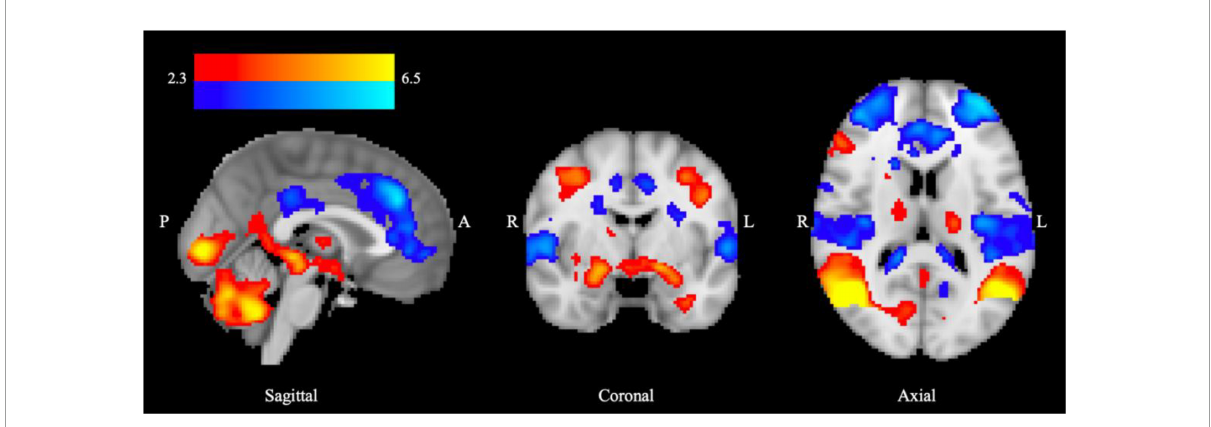
FIGURE1 BOLD response to aversive processing in all groups combined following placebo administration. Increased limbic BOLD signal across HD and DD groups for the aversive > neutral contrast is denoted in red, and decreased fronto-cortical BOLD signal indicated in blue. Color bar shows z -stat values representing average BOLD signal change across groups using FSL’s FLAME-1, mixed-effects analysis ( n = 68, Z > 2.3, P < 0.05), controlling for center and age. MNI coordinates: x = 0.5 (sagittal), y = –4.7 (coronal), z = 13.7